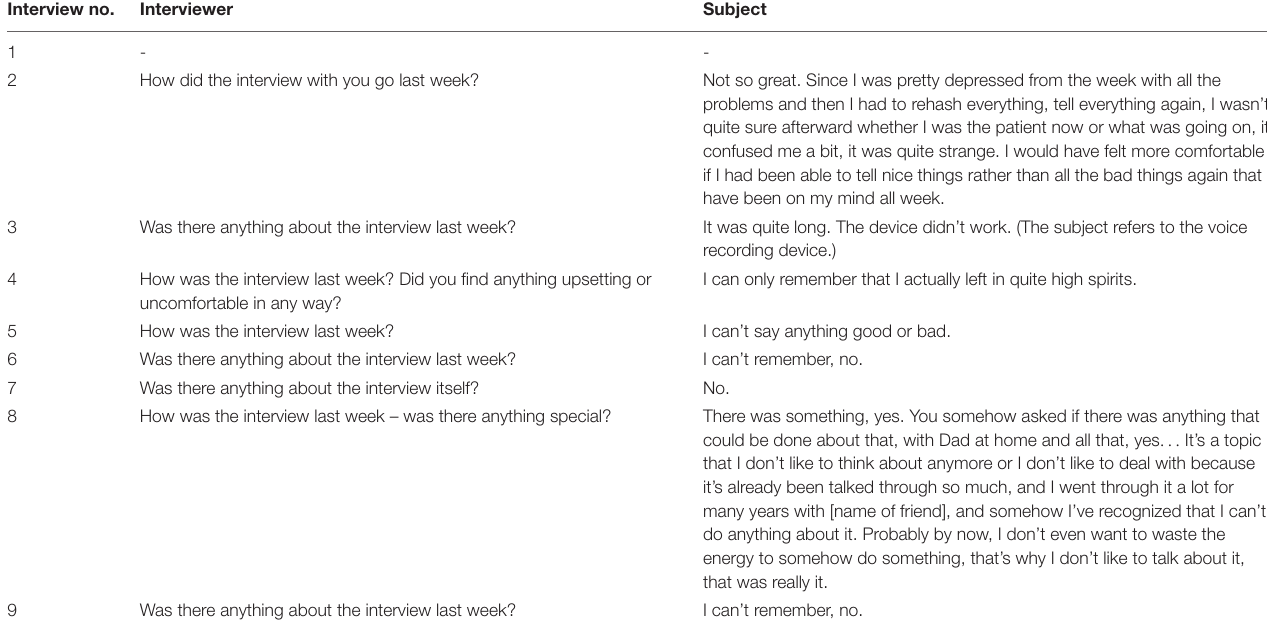
TABLE 1 | Excerpts from the weekly in-depth interviews referring to the previous week’s interview. Interview